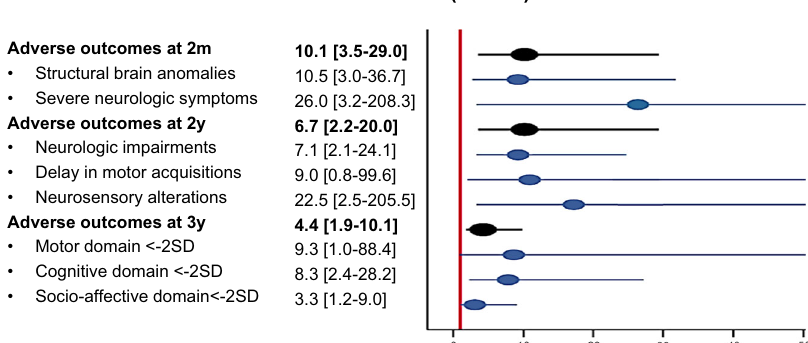
Fig. 2 Main outcomes at 2 months, 2 years, and 3 years of life. Relative risks of adverse outcomes at 2 months (m), 2 years (y), and 3 years of life, associated with laboratory-con fi rmed congenital Zika infection at birth are estimated using generalized linear models, adjusted on maternal infection diagnosed in the fi rst trimester, and presented with 95% con fi dence intervals (95% CI). SD standard deviations. Table 3 Neonatal and early infantile outcomes, from birth to 2 months of